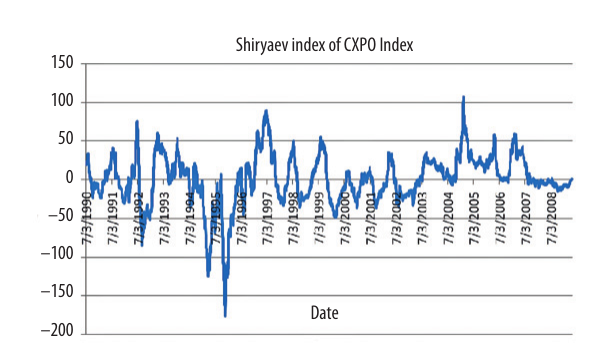
Fig. 4. Shiryaev-Zhou index of Germany’s securitized real estate